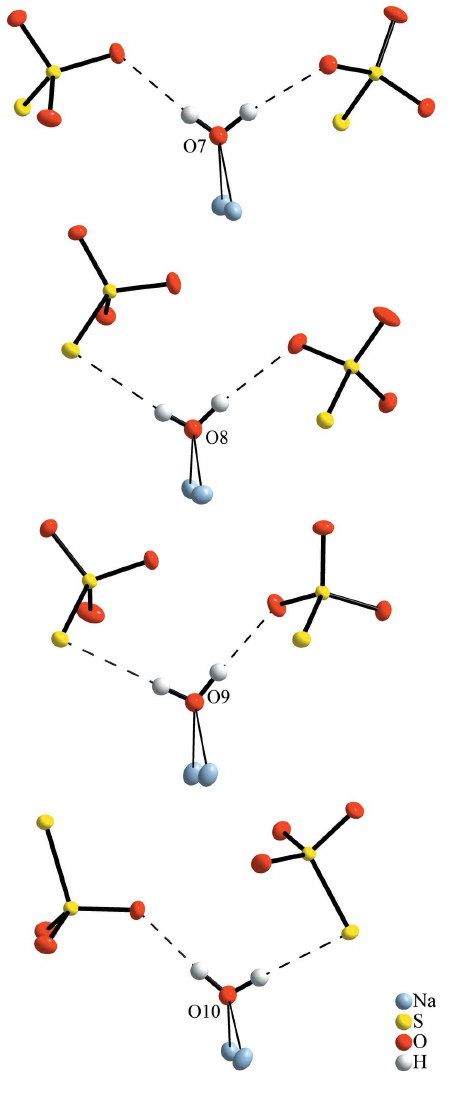
Figure 4 Environments of the crystal water molecules in Na 2 S 2 O 3 (cid:2) 2H 2 O. Anisotropic displacement ellipsoids of non-H atoms are drawn with a probability of 80%, hydrogen bonds as dashed lines, and short contacts to coordinating Na + ions as thin lines.